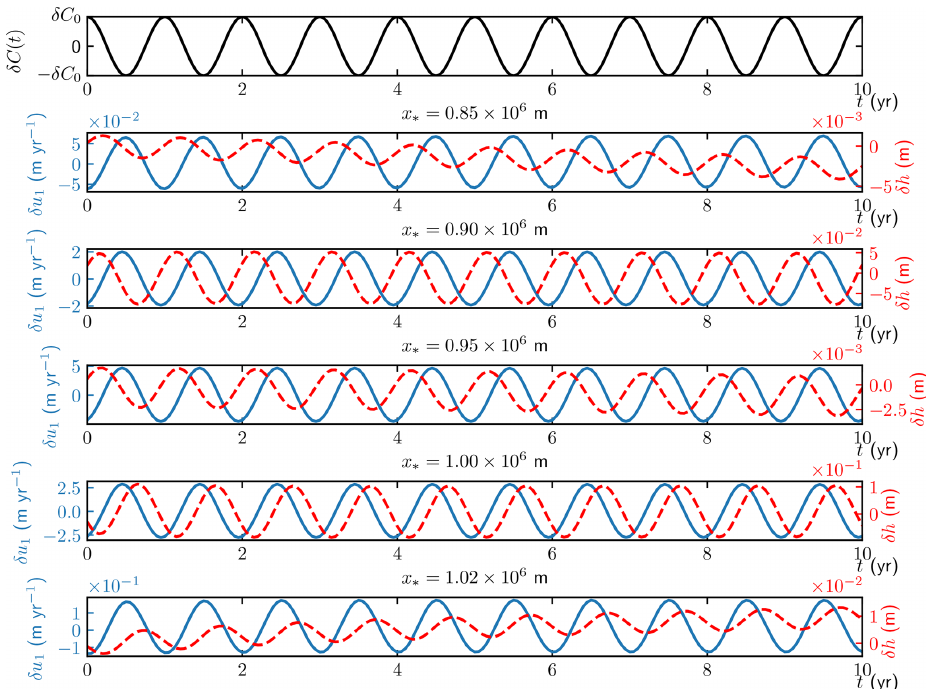
Figure 3. Observations at x ∗ = 0 . 85 , 0 . 9 , 0 . 95 , 1 . 0 , 1 . 02 × 10 6 m with FS in time t ∈ [ 0 , 10 ] of δu 1 (solid blue) and δh (dashed red) with perturbation δC(t) = 0 . 01 C cos ( 2 πt) for x ∈ [ 0 . 9 , 1 . 0 ]× 10 6 m. Notice the different scales on the y